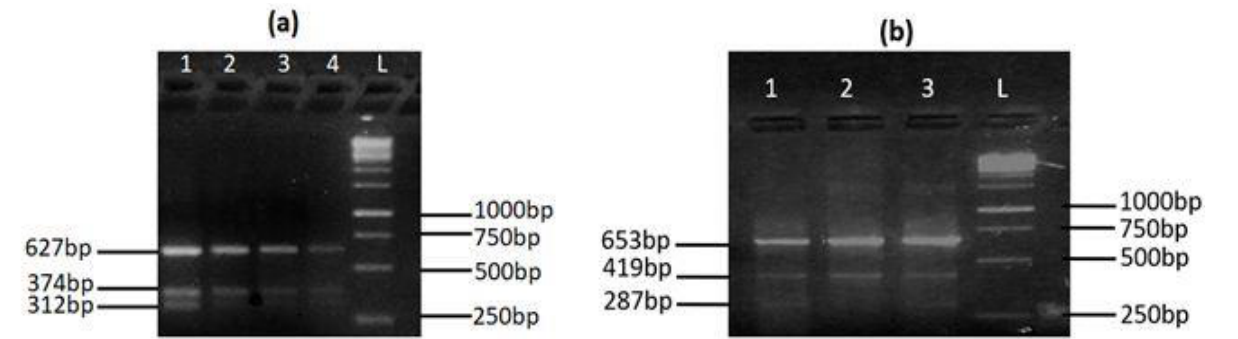
Figure 1. Tetra ARMS-PCR assay results for the genotypes of ( a ) MYH7 rs121913642 and ( b ) MYH7 rs121913645.